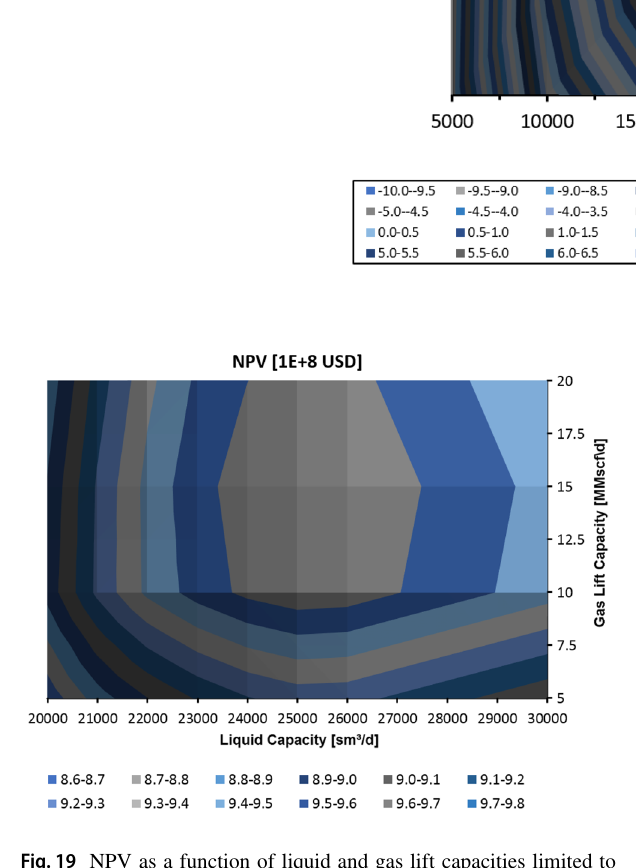
Table 5 NPV (in 1E8 USD) as a function of liquid rate and gas lift capacities